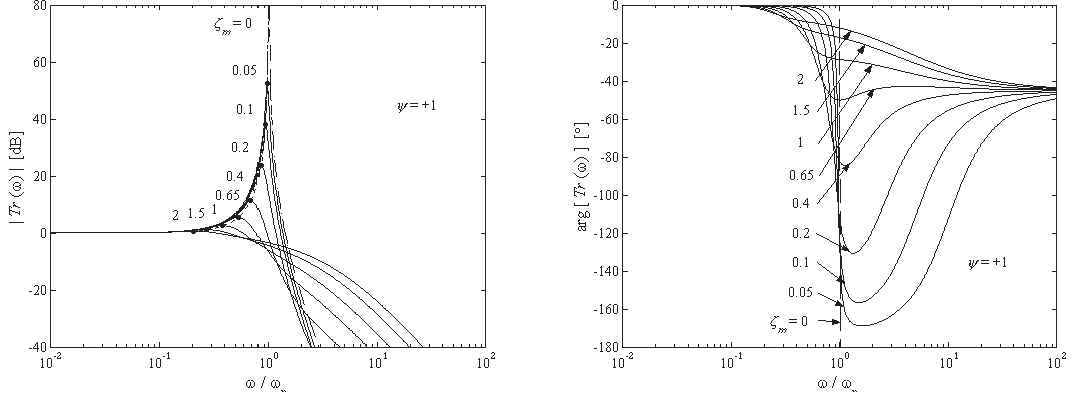
Fig. 17. Modulus (left) and phase (right) of TRF for ψ = 1